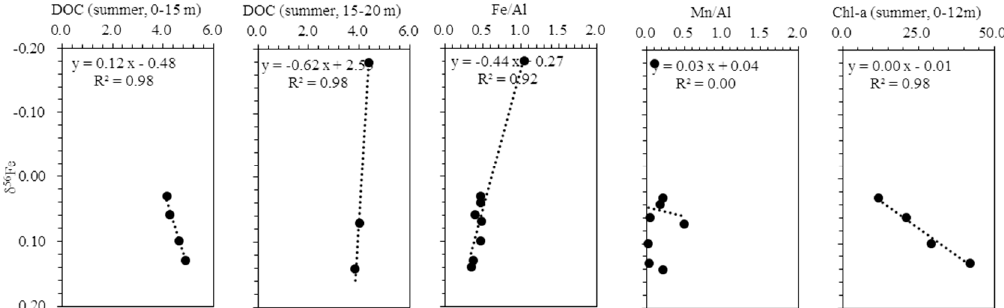
Figure 4. Correlations between δ 56 Fe values and the corresponding Chl-a, DOC, Fe/Al, and Mn/Al values in the summer SPM in Hongfeng Lake.